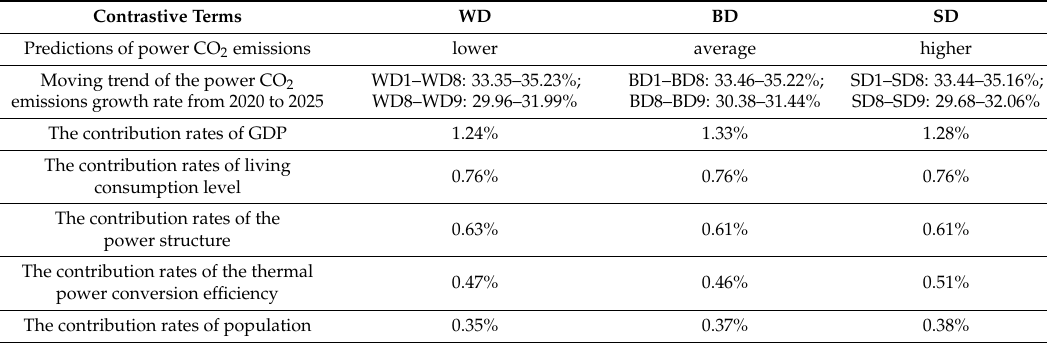
Table 8. Comparison results of the three essential development scenarios from 2018 to